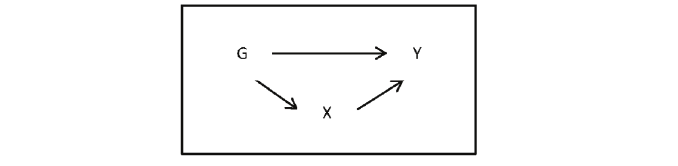
Fig 2. Graphical representation of the